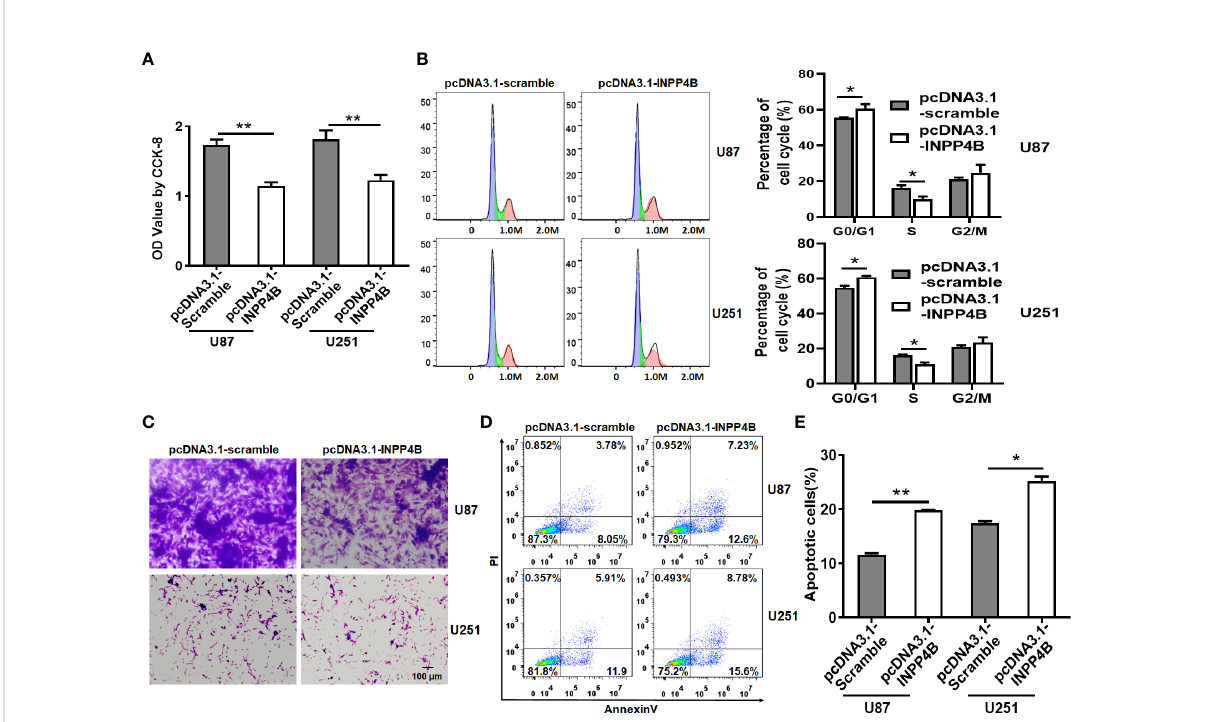
FIGURE 2 INPP4B overexpression inhibits the proliferation and migration of glioma cells, and increases their susceptibility to apoptosis. Human U87 and U251 glioma cells transfected with scramble (pCDNA3.1-Scramble) or INPP4B-overexpressing (pCDNA3.1-INPP4B) vector were assessed for (A) viability by CCK-8 assay; (B) cell growth by cell cycle assay; (C) migratory properties by transwell migration assay; and (D, E) survival to apoptosis, by Annexin V/PI staining and fl ow cytometry. Values represent the means ± SD (n = 3); * p < 0.05, ** p <